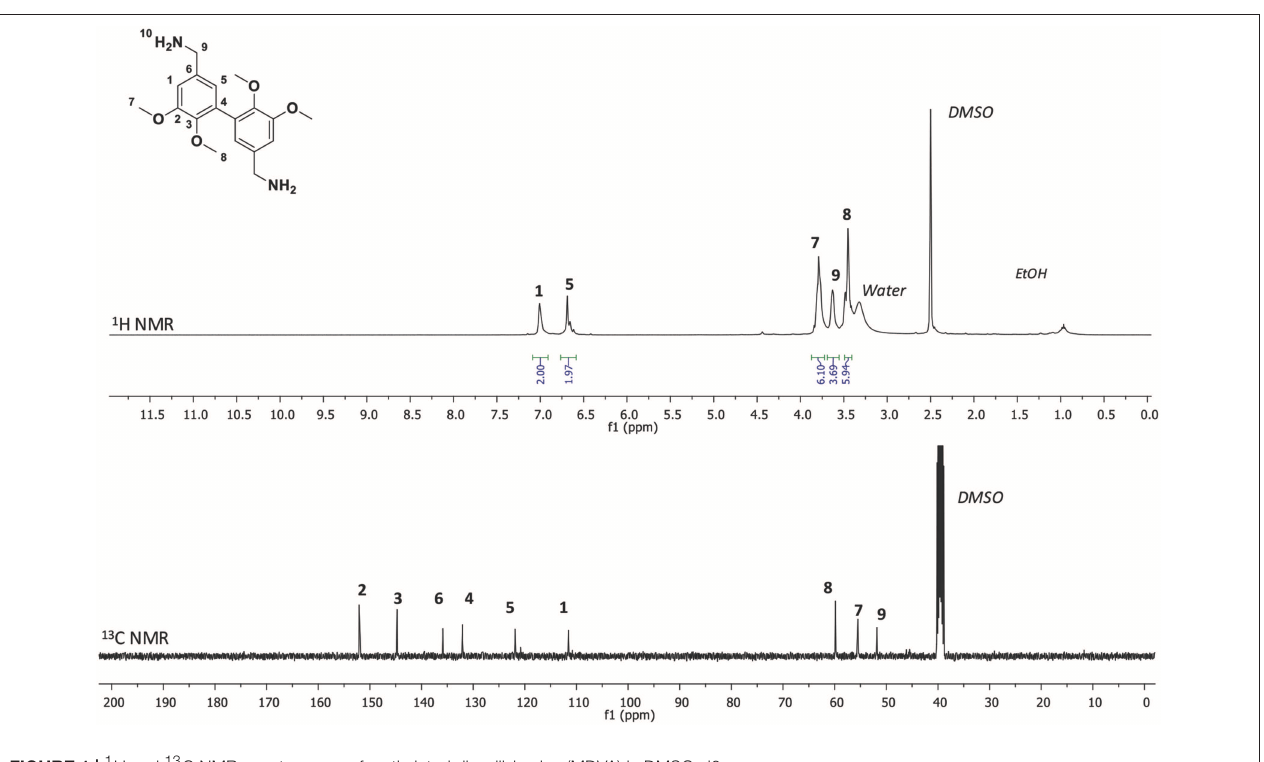
FIGURE 1 | 1 H and 13 C NMR spectroscopy of methylated divanillylamine (MDVA) in DMSO-d6.